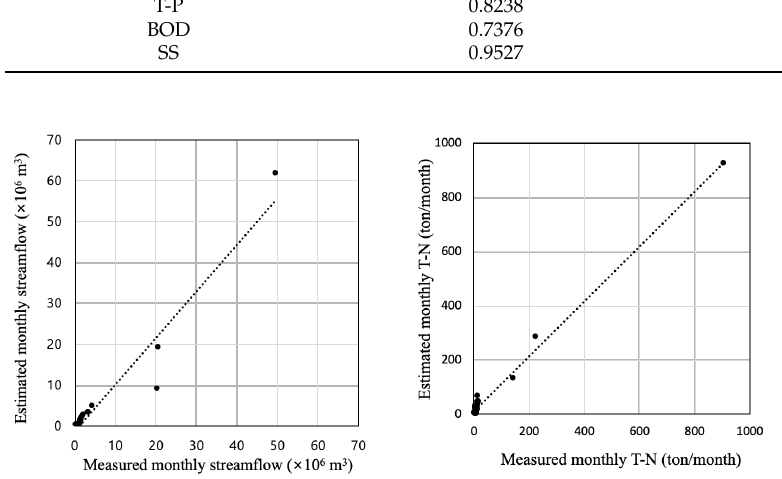
Table 4. NSE and R 2 for measured and estimated monthly streamflow in model validation. NSE R 2 Streamflow